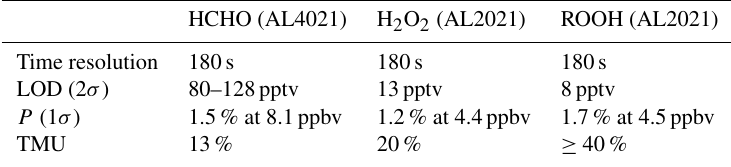
Table 1. Instrument characteristics of the HCHO and hydroperoxide measurements during the AQABA campaign. HCHO